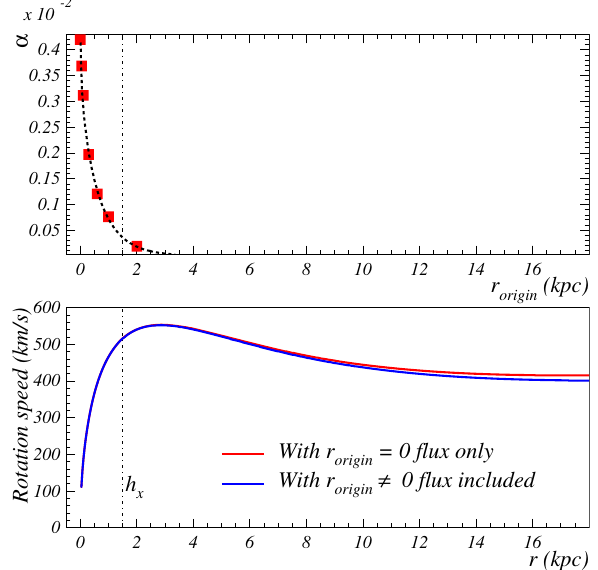
Fig. 8 Top panel: The parameter α characterizing the non-Newtonian fluxbehavior,vs. r origin .Bottompanel:Galacticrotationcurveaccount- ing for the fact that fluxes originate at different r origin (blue line). The red line shows the result if the full flux is approximated to originate at r =